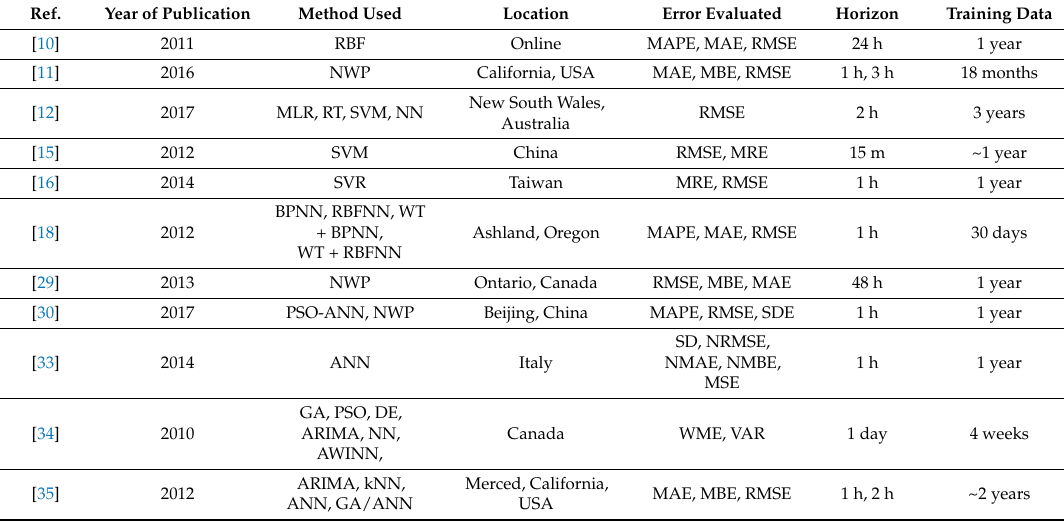
Table 1. Overview of different forecasting